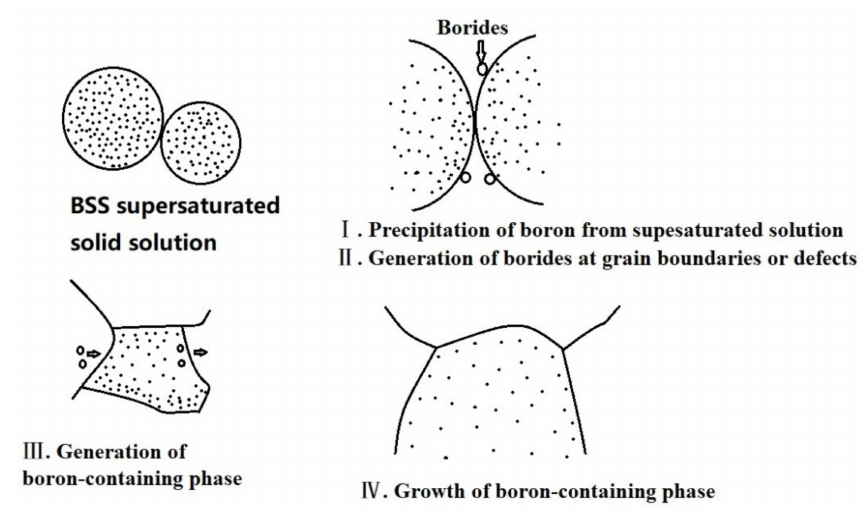
Figure 14. Drawing of boron-containing phase growth